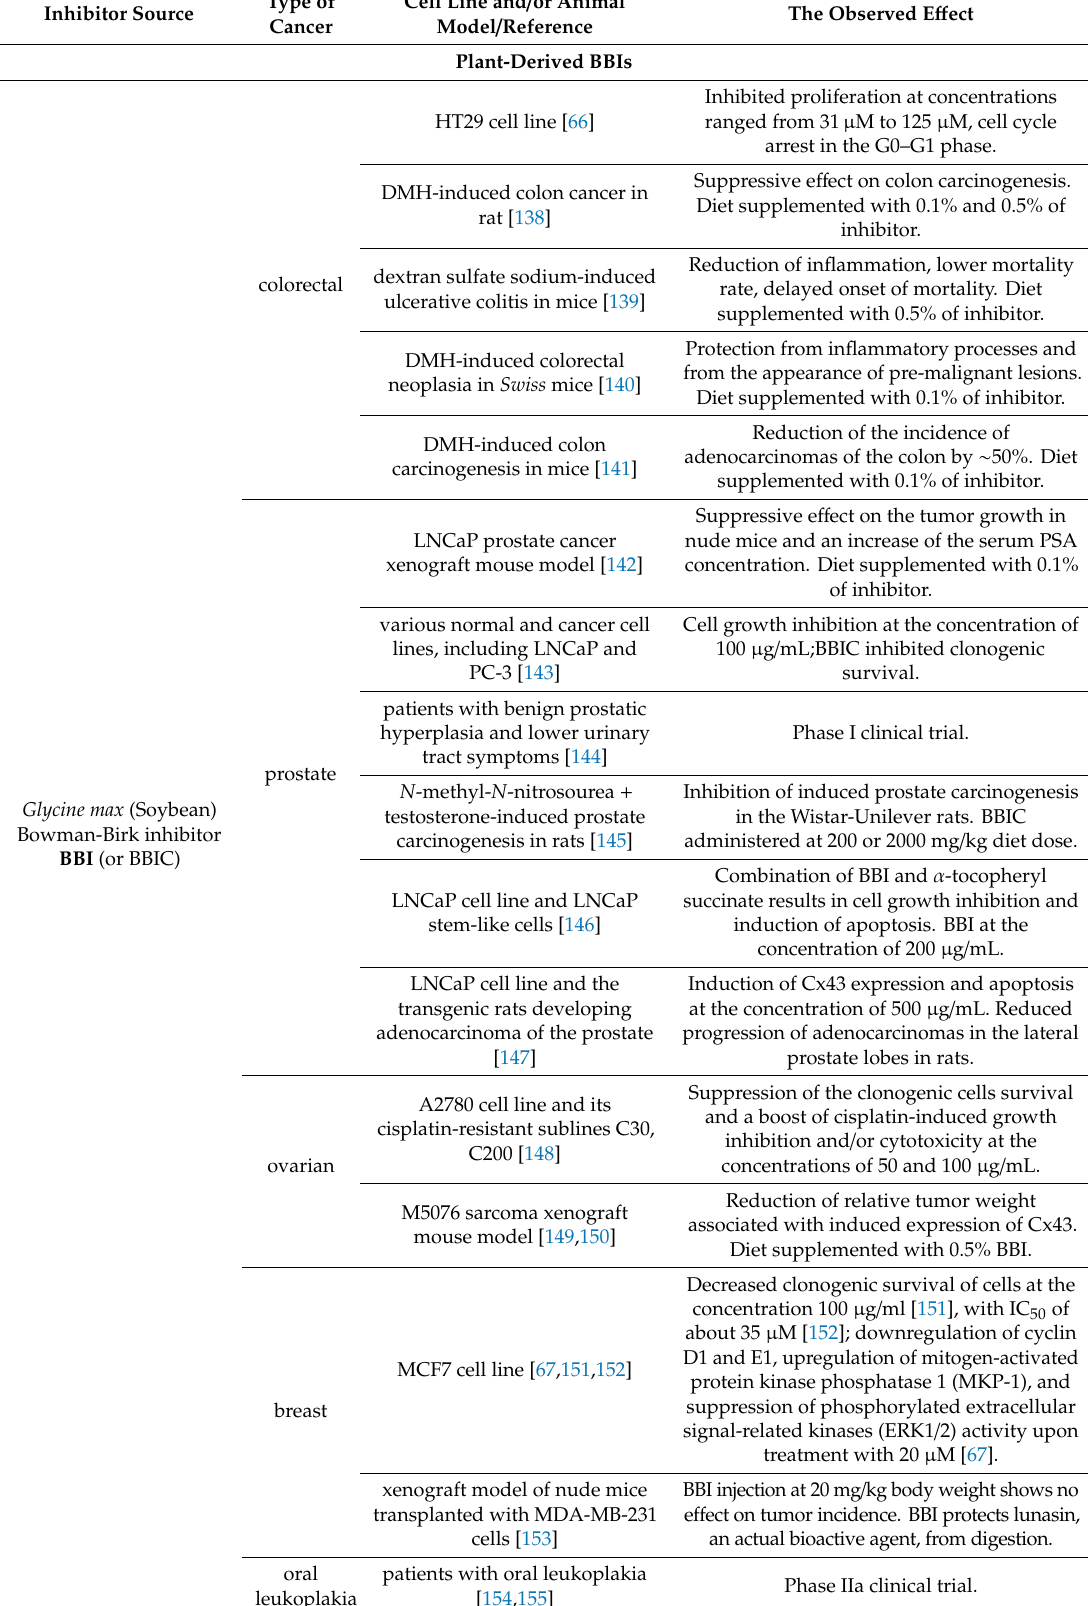
Table 3. Anti-cancer properties of BBIs and